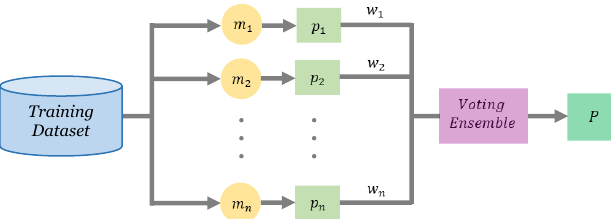
Figure 4. Voting Ensemble combines predictions p i of multiple classifiers m i using weighted average w i to compute a final prediction P